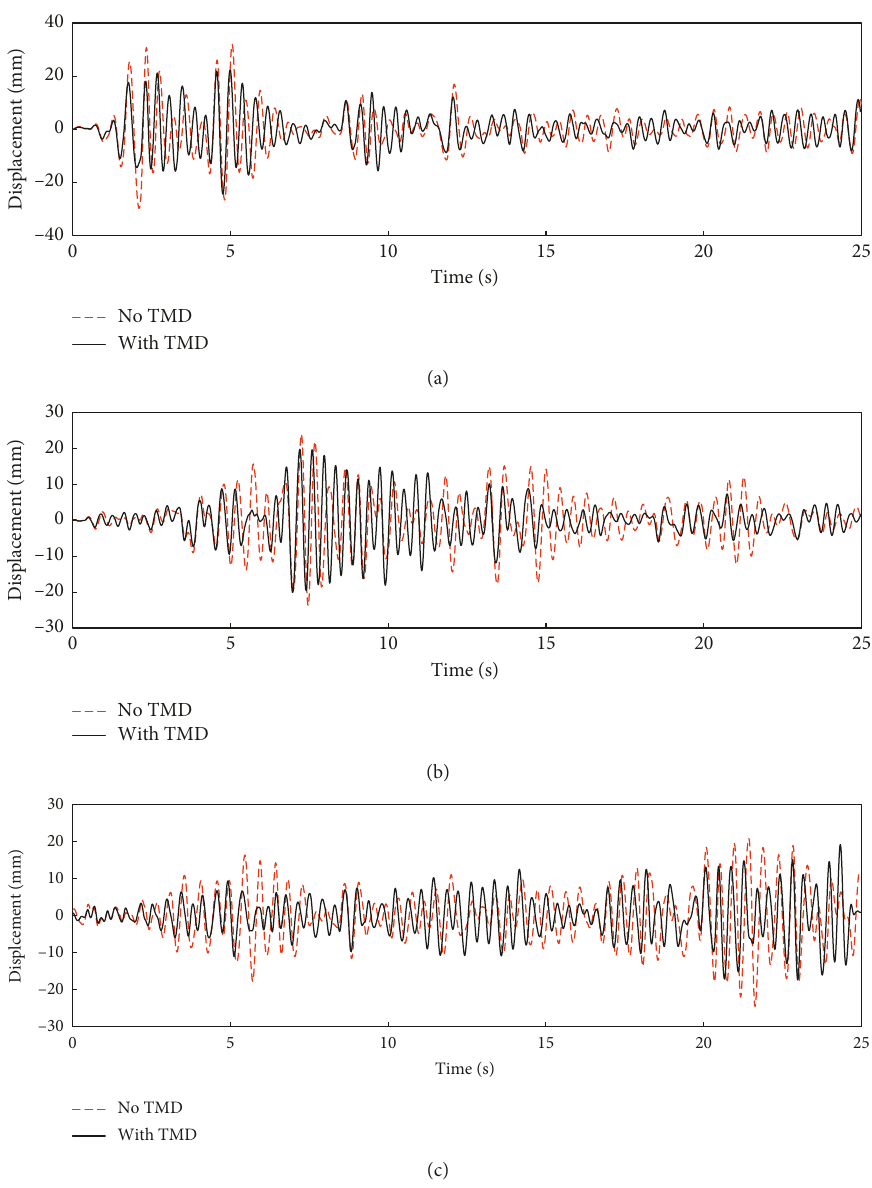
Figure 9: Displacement responses of the platform subjected to the three earthquake-induced seismic waves by simulation. (a) Displacement time series under the El-Centro NS seismic wave by simulation; (b) displacement time series under the Taft EW seismic wave by simulation; (c) displacement time series under the Fukushima NS seismic wave by